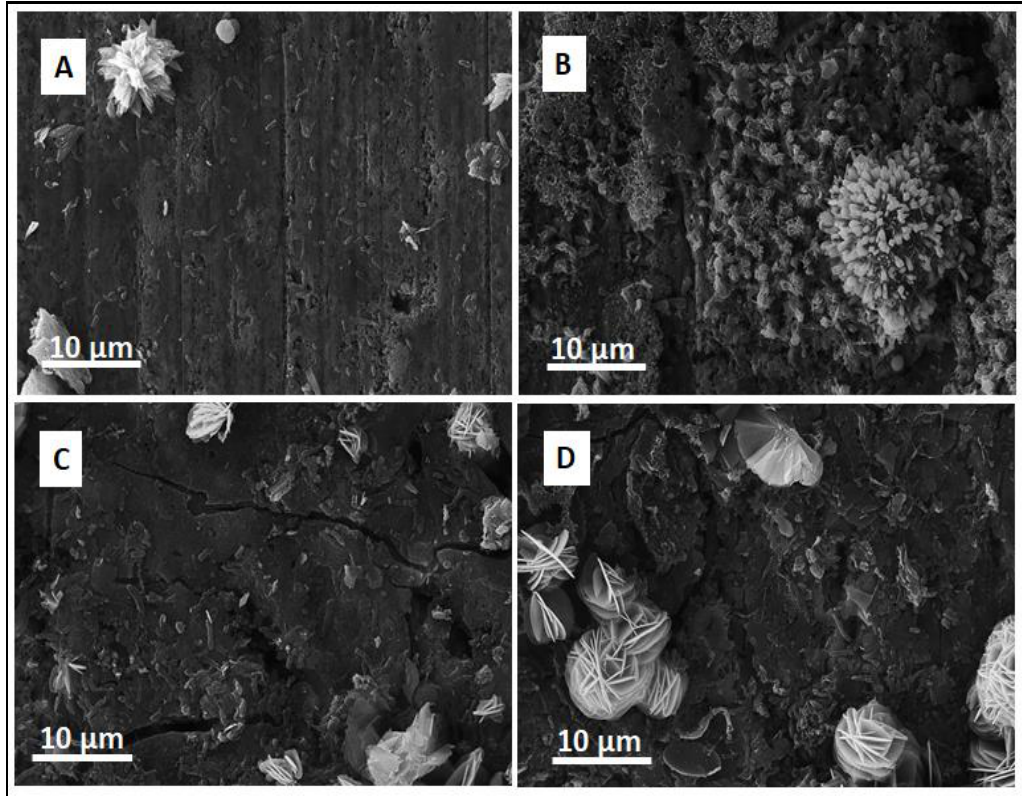
Figure 2. SEM images of copper after different periods of exposure: ( A ) 3 months; ( B ) 8 months; ( C ) 12 months; and ( D ) 24 months.